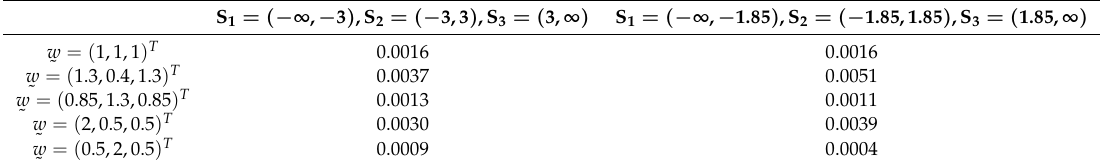
Table 5. CWKL divergence between P and Q in two different partitions of the support.